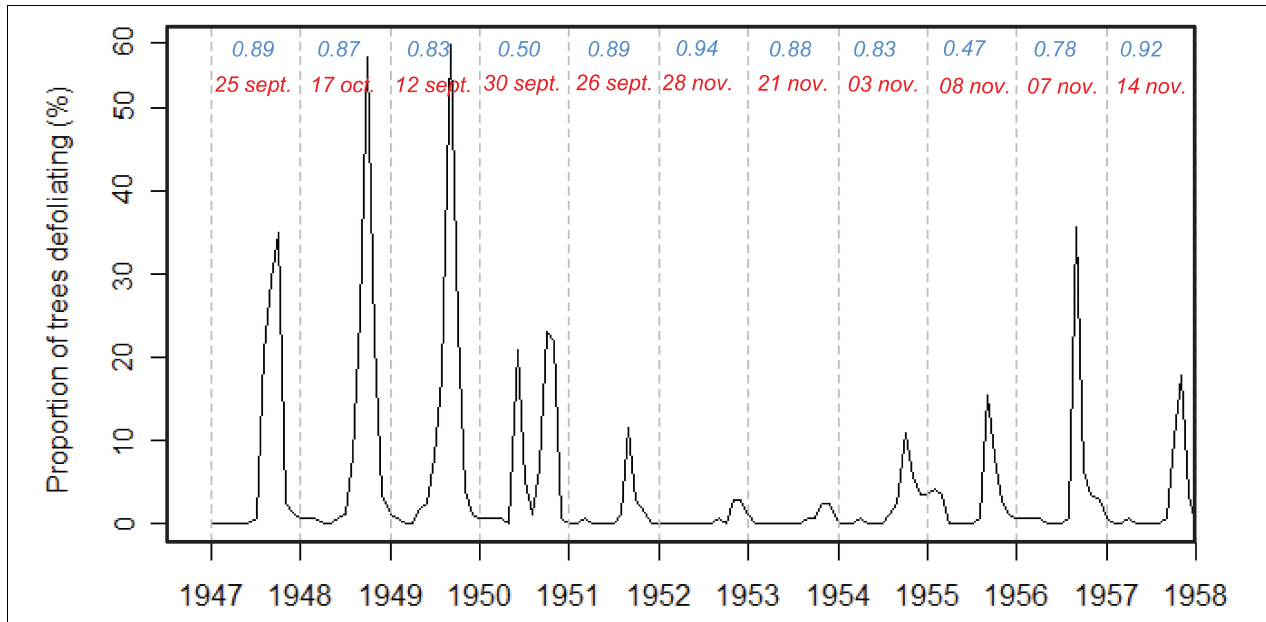
FIGURE 4 | Defoliation of P. balsamifera based on phenological observations from 1947 to 1957. The result of circular statistics of defoliation for the population (194 trees) is given for each year. Specifically the strength of synchronicity between trees as given by the rho (in blue) and the mean peak date (in red).